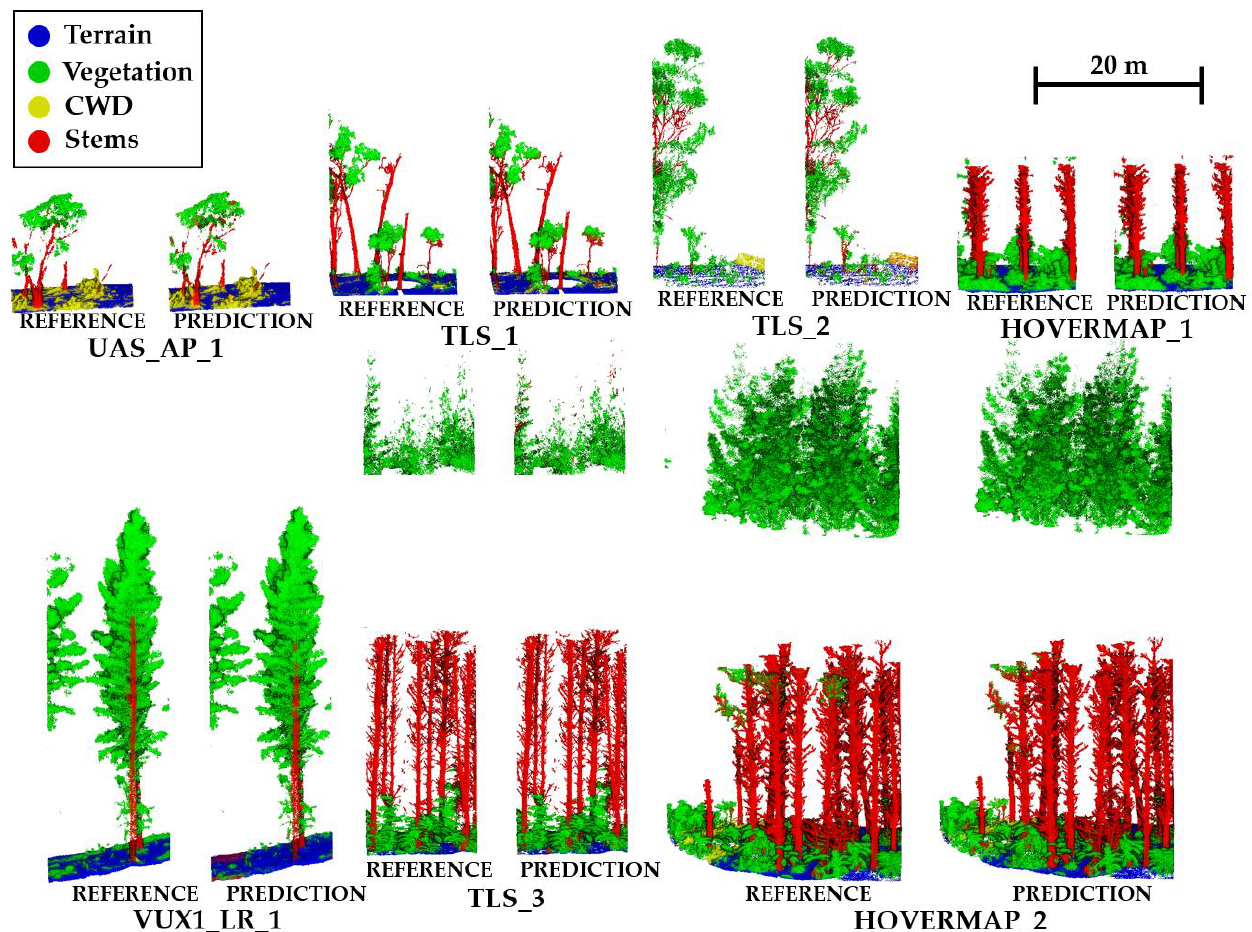
Figure 7. Visualization of the semantic segmentation results. For each pair, the left point cloud shows the manually labeled reference and the right point cloud is the model’s label predictions. The predicted labels are visually very similar to the reference dataset, with the most obvious differences being the few misclassifications of coarse woody debris (CWD) as stems in TLS_2, and some terrain being misclassified as stem in VUX_1LR_1.